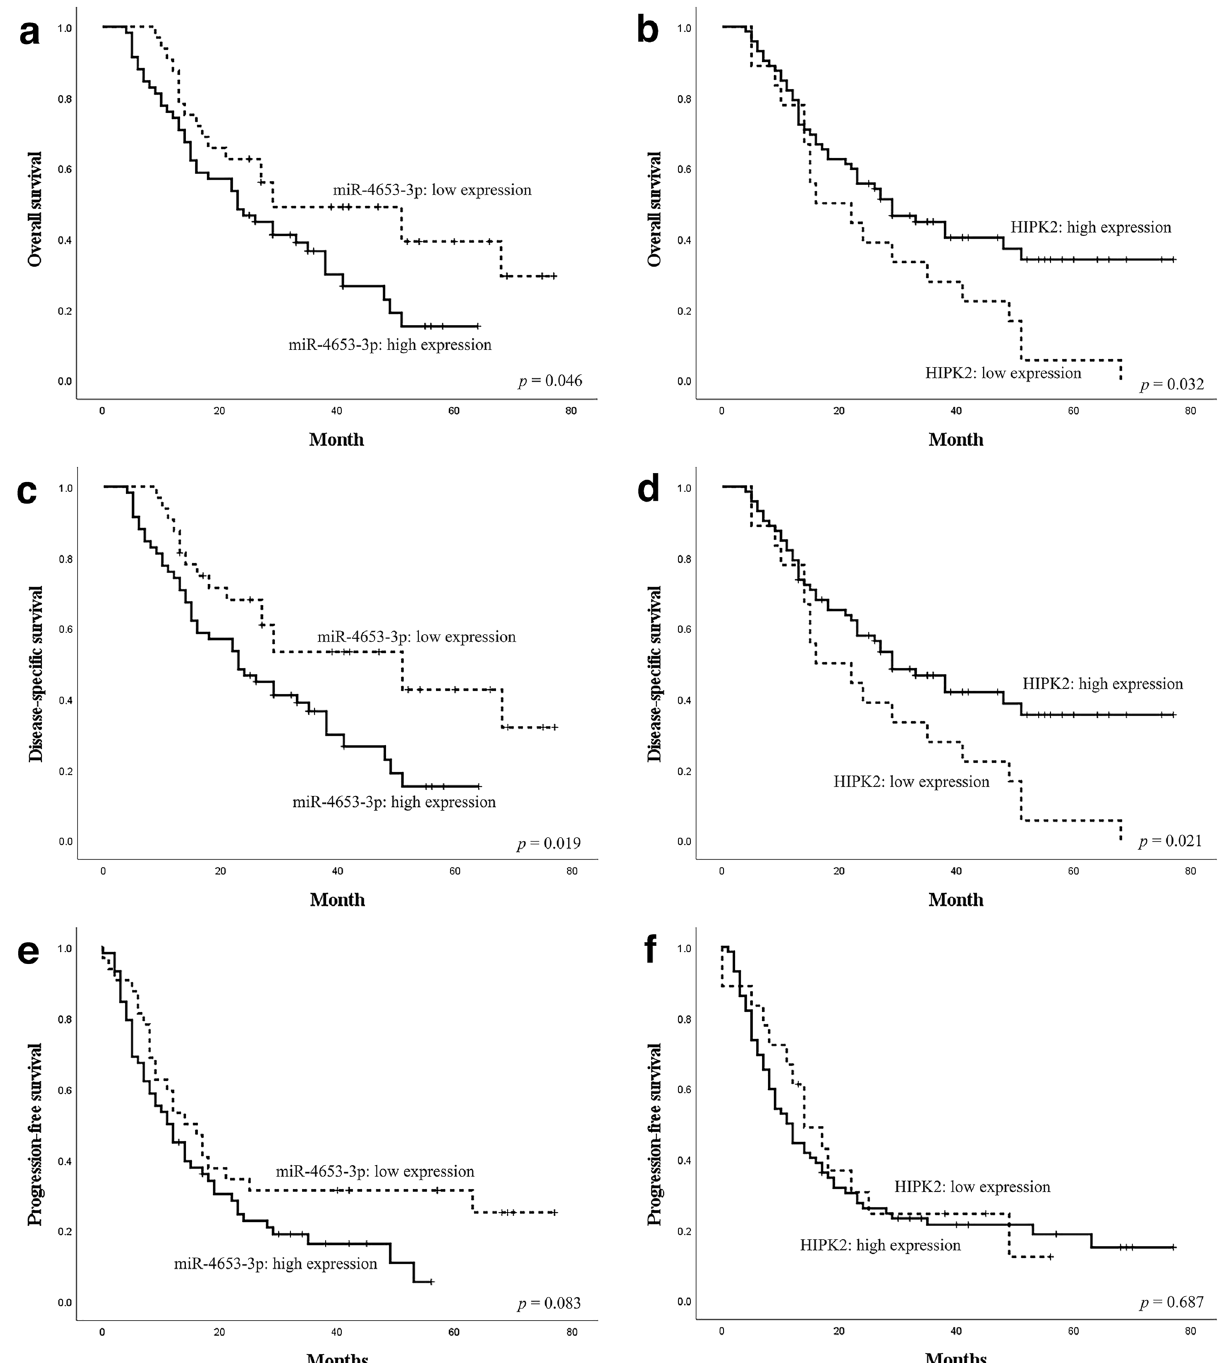
Figure 3. Survival analysis of patients with pancreatic ductal adenocarcinoma in relation to the expression of miR-4653-3p and HIPK2. High miR-4653-3p expression was associated with shorter overall ( a ) and disease- specific survival ( c ). In contrast, low HIPK2 expression was associated with shorter overall ( b ) and disease- specific survival ( d ). There was no significant difference in the association between progression-free survival and the expression of miR-4653-3p ( e ) and HIPK2 ( f